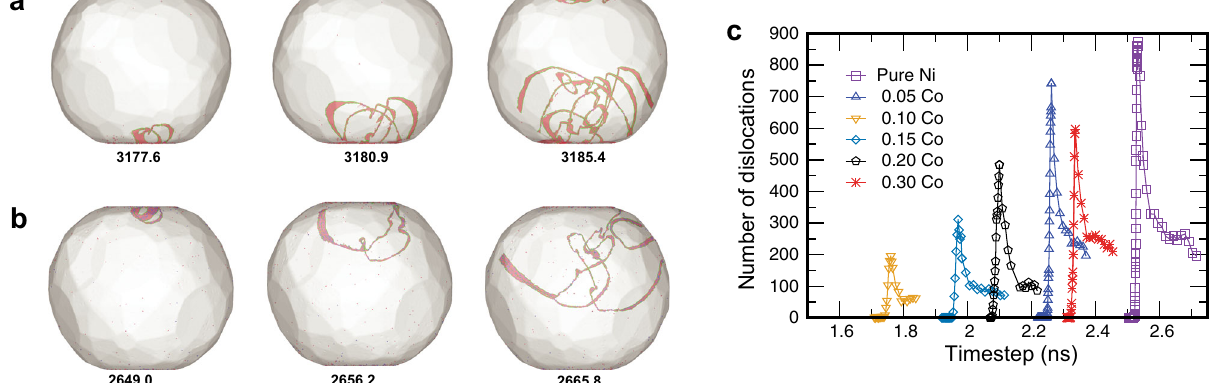
Fig. 6 Dislocation processes at early stages of plastic deformation. Dislocation nucleation and multiplication in 60 nm nanoparticles of ( a ) Ni and ( b ) Ni- 0.5Co. The numbers indicate the time (in picoseconds) from the start of the simulation. The dislocations are visualized by the DXA algorithm with the red atoms representing stacking faults. Non-dislocated atoms are invisible. c Number of dislocation segments in 35 nm nanoparticles for several chemical